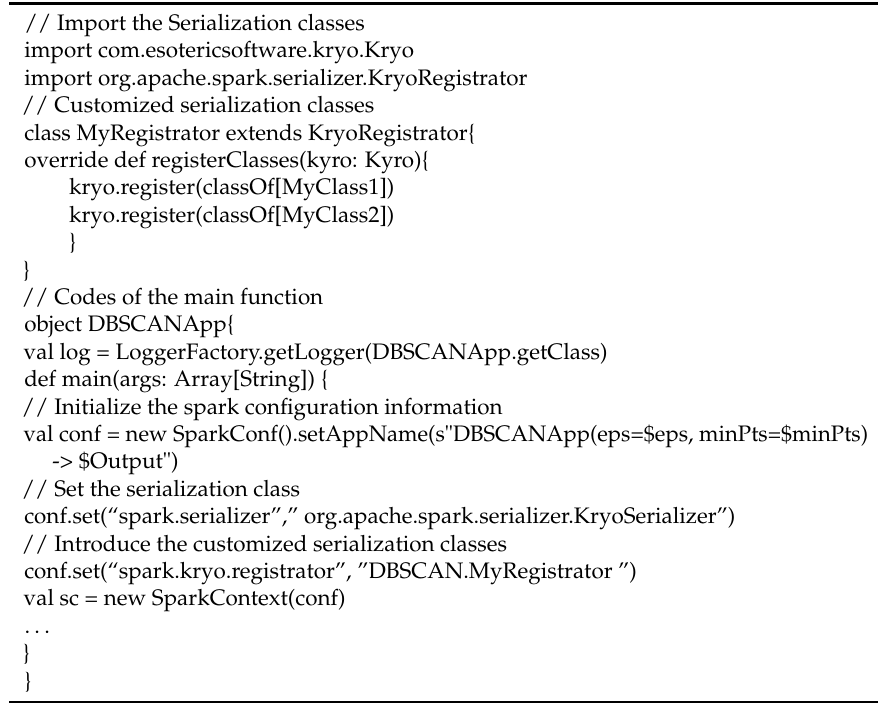
Table 4. The pseudo codes for Optimization Method 2.